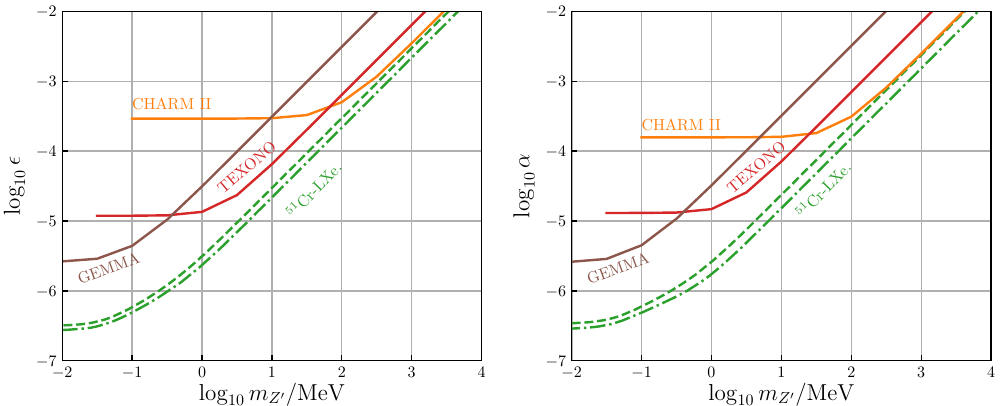
Figure 7 . Constraints on the mass mixing α and kinetic mixing (cid:29) of light Z of TEXONO, CHARM II, and GEMMA are taken from ref. [34]. The green dashed curve is for 51 Cr-LXe with configuration A, and dot-dashed for configuration C. Configuration B is not shown here for simplicity, which should be between the dashed and dot-dashed